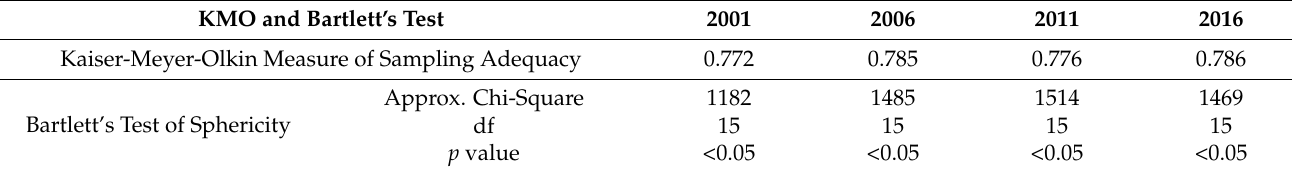
Table 2. KMO and Bartlett’s Test.